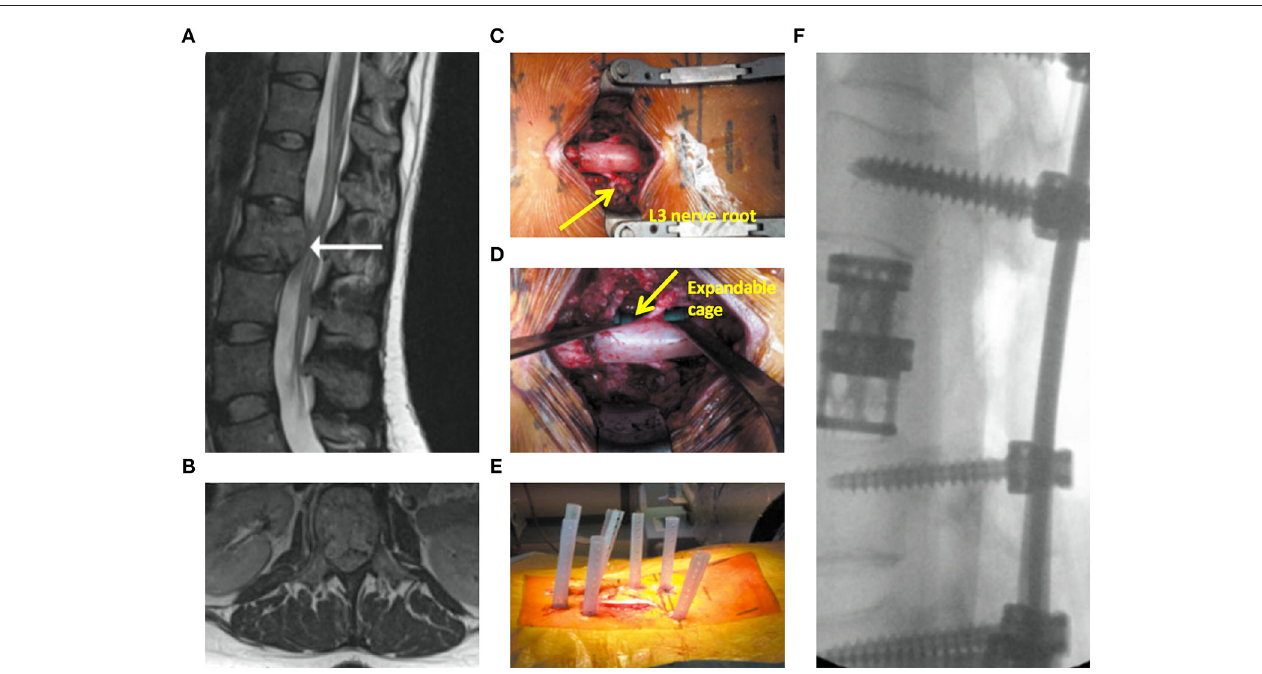
FIGURE 4 | Expandable cage-assisted treatment (39). A 32-year-old female presented with mid-back pain and leg weakness > 3 weeks. (A,B) Magnetic resonance imaging images showing a solitary L2 lesion causing compression of the circumferential cauda equina. (C) Intraoperative photograph showing a mid-line incision with circumferential decompression and vertebrectomy. Decompressed L3 nerve roots are displayed (arrow). (D) Intraoperative photograph showing expandable cage (arrow)-assisted reconstruction of the vertebral body. (E) Intraoperative photograph showing a mid-line wound closure and percutaneous fixation two levels above and below the vertebrectomy. (F) Postoperative